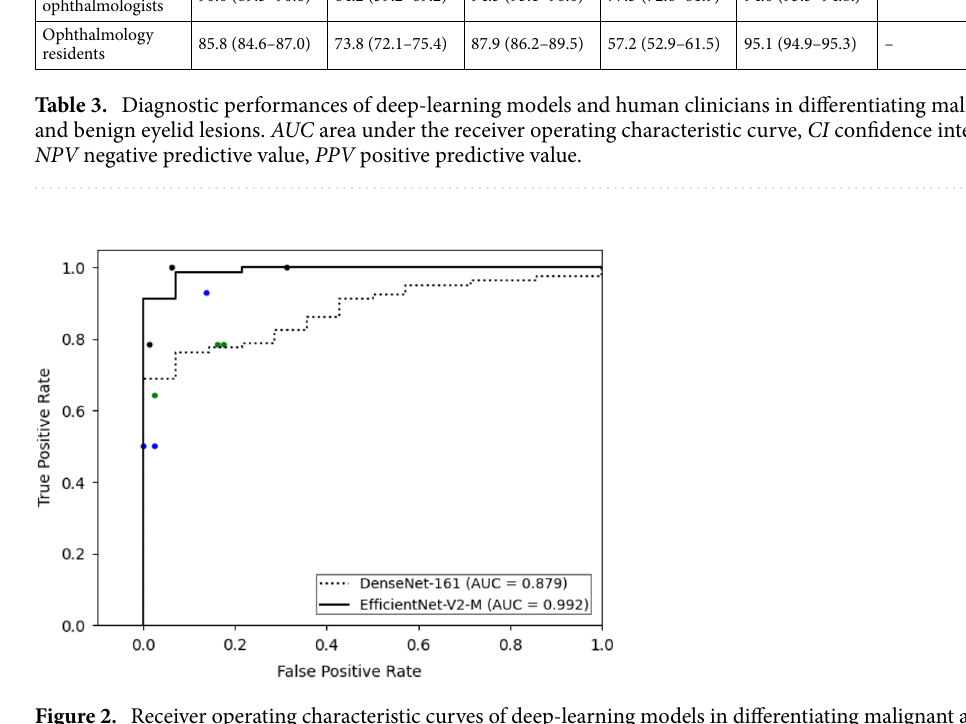
Figure 2. Receiver operating characteristic curves of deep-learning models in differentiating malignant and benign eyelid lesions. The diagnostic performances of nine ophthalmology clinicians on the same test set are shown by single dots. Black dots indicate the diagnostic performances of oculoplastic specialists, blue dots are those of board-certified general ophthalmologists, and the green dots are those of ophthalmology